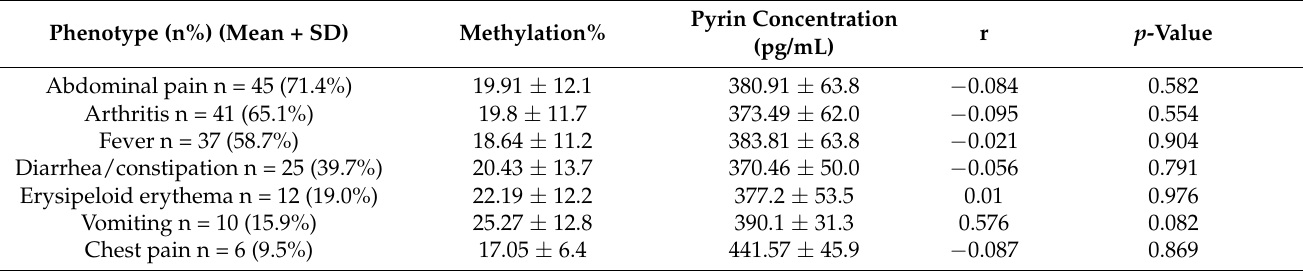
Table 6. Correlation of the methylation % and pyrin concentration with the phenotype of